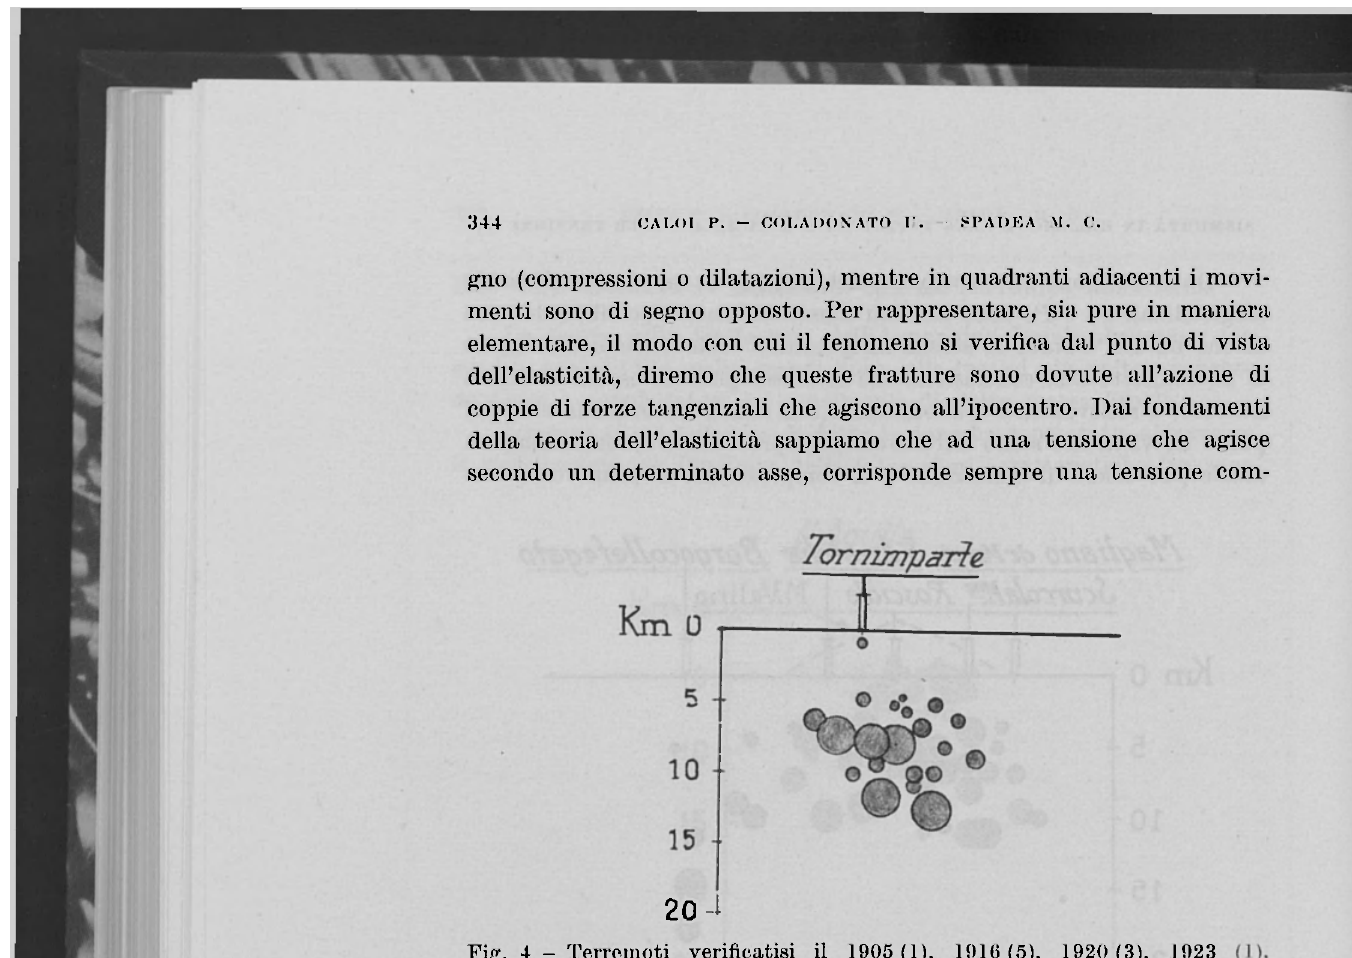
Fig. 4 - Terremoti verificatisi il 1905 (1), 1910 (5), 1920(3), 1923 1929 (12). Magnitudo: 3 < M <